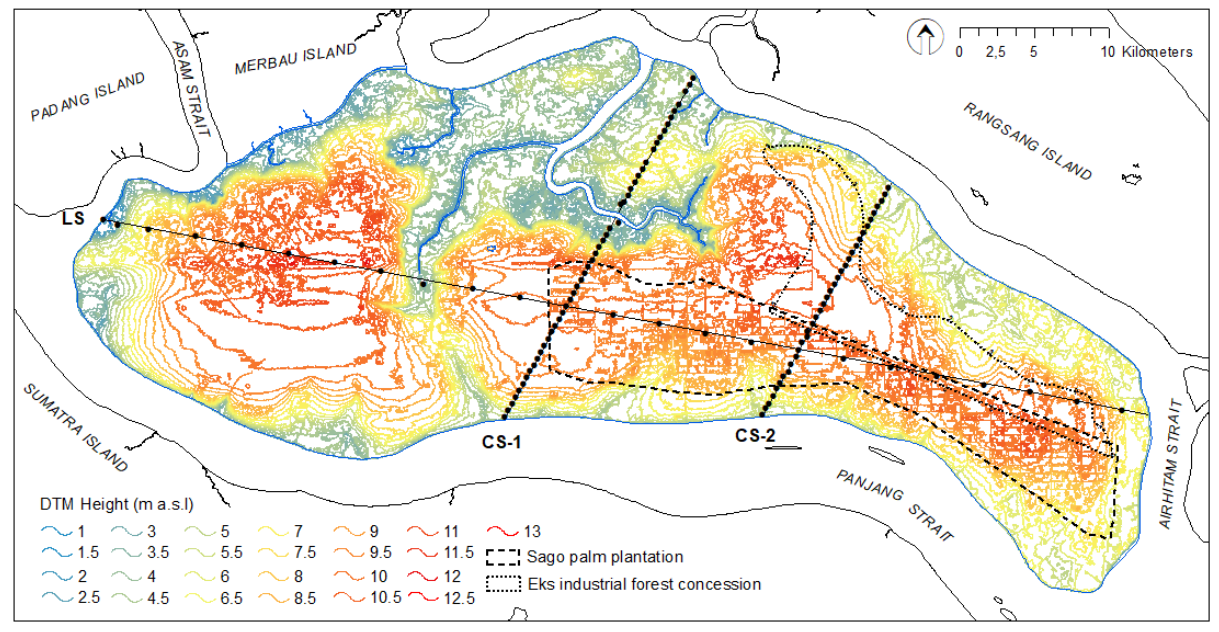
Figure 3. Contour map of Tebing Tinggi Island derived from the DTM shown in Figure 2, with the three survey transects (LS, CS1 and CS2) and outlines of industrial plantation areas